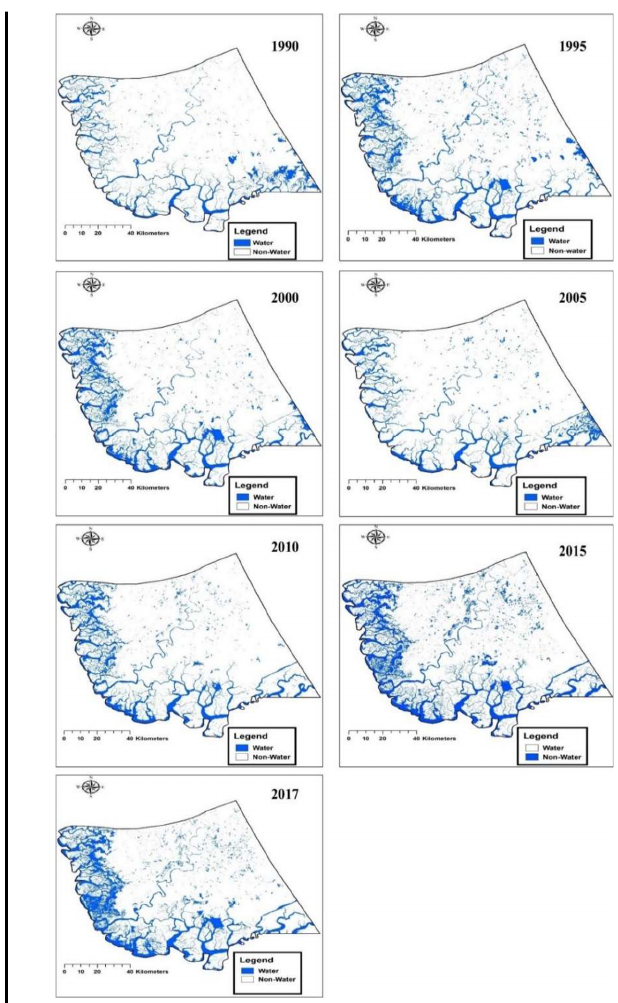
FIG. 5. WATER MASKS OF THE INDUS DELTA FROM